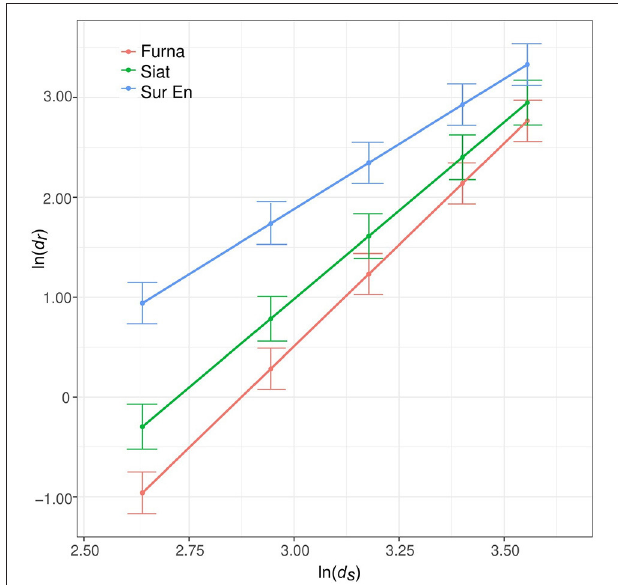
FIGURE 2 | Root–stem long-term allometry α (1970–2016) from the fitted model according to Equation (4). Its coefficients are shown in Table 3 . Points indicate model estimates at five different stem radii covering a range of ds from 13 to 37cm, and whiskers are the SE, with dr and ds being the root and stem radii (mm).